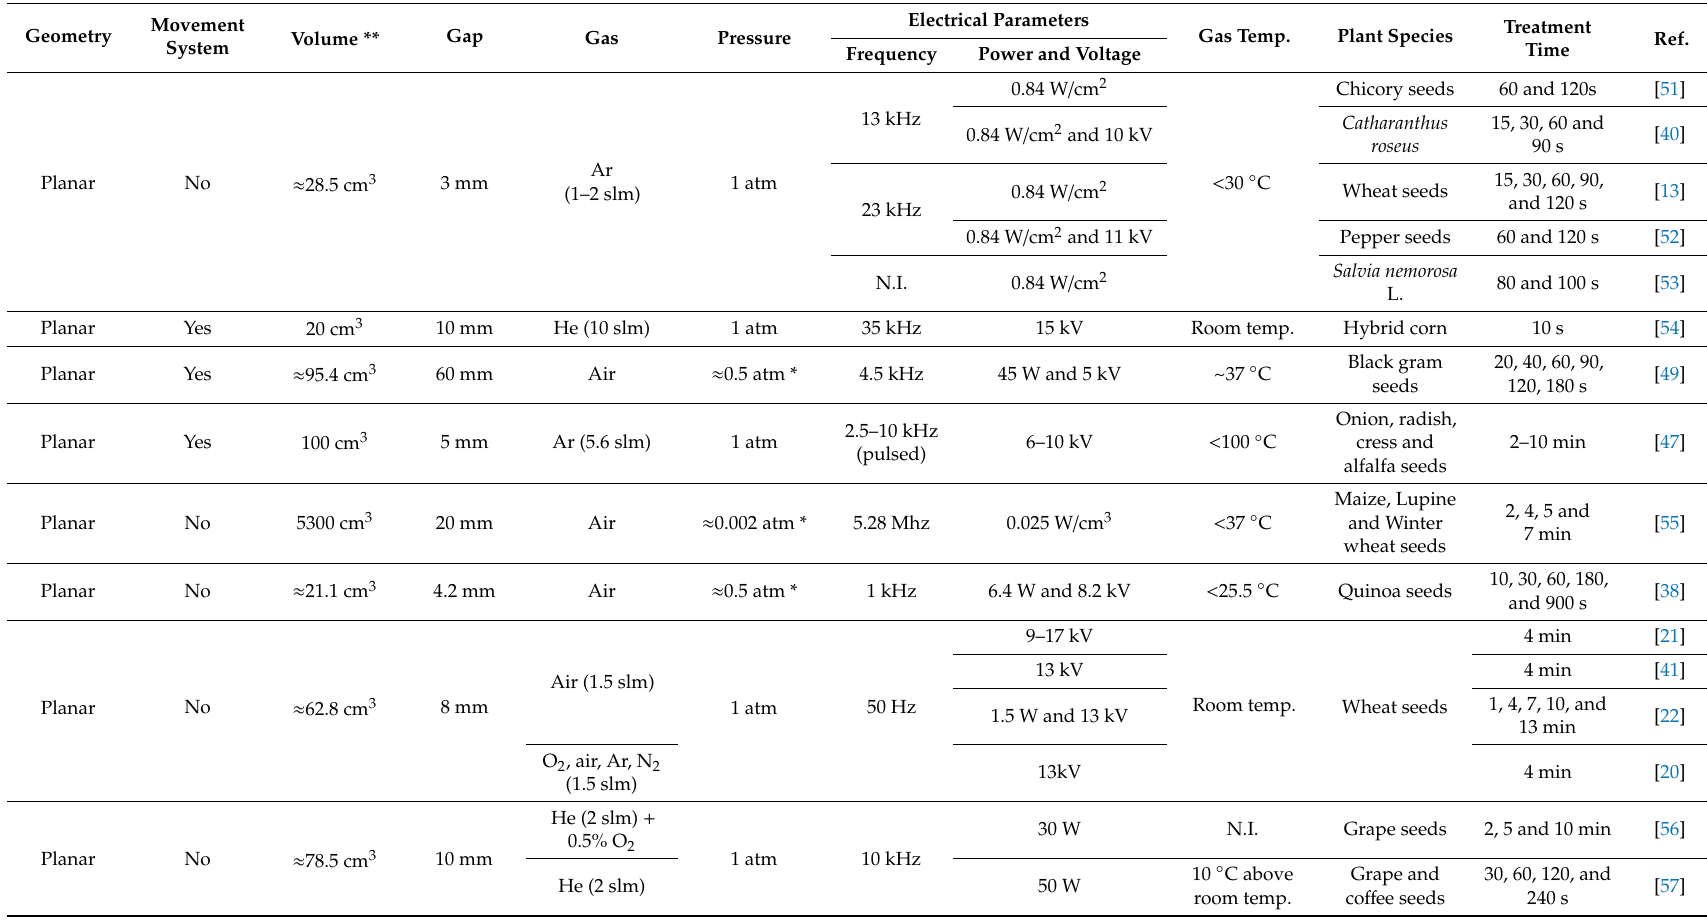
Table 1. Literature overview of dielectric barrier discharge (DBD) reactors used for seed treatment in the last 5